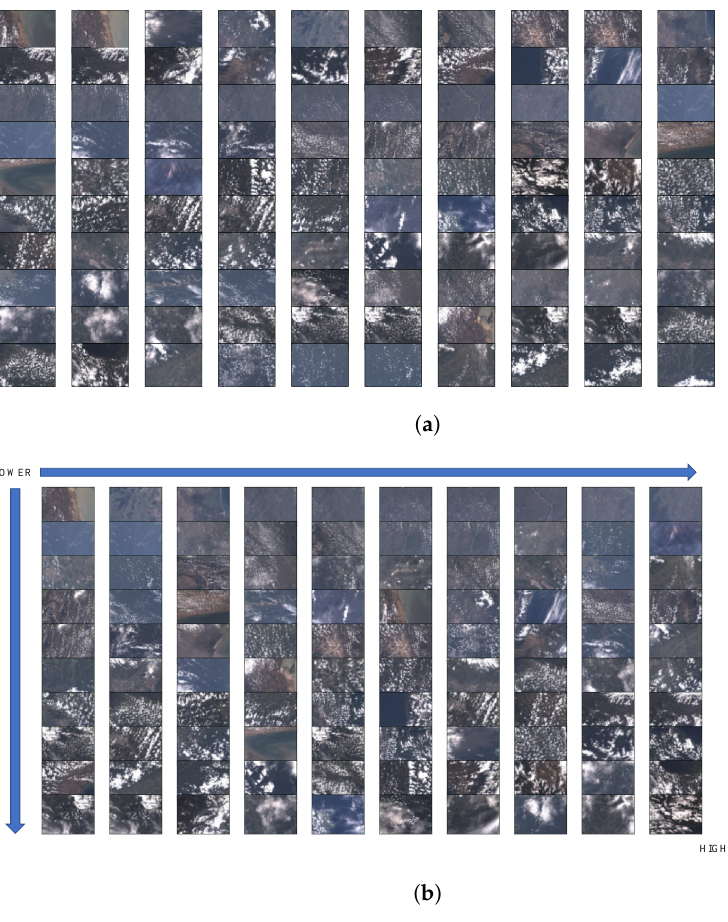
Figure 6. NU-Net-mod results under unseen domaing: images from FACSAT-1. ( a ) Sample of thumbnail images from FACSAT-1; ( b ) Rank thumbnail images from